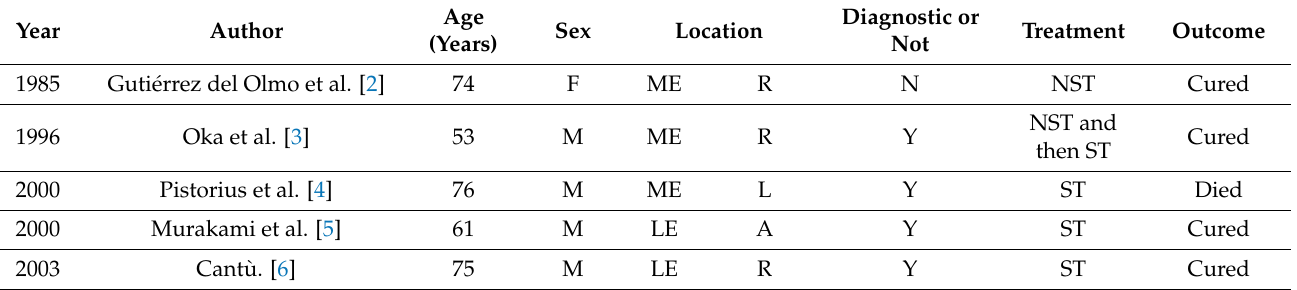
Table 1. Baseline characteristics of 13 patients with spontaneous rupture of esophageal diverticu- lum.